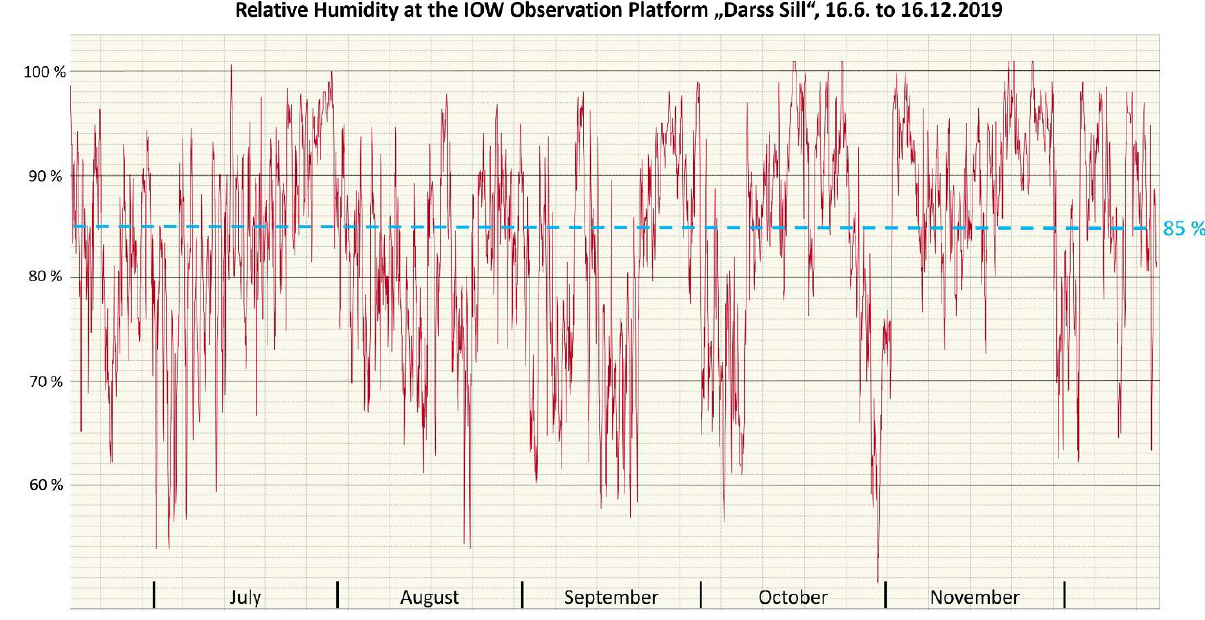
Figure 4. Recorded RH values from 16 June till 16 December 2019 at the IOW observation platform “Darss Sill”, located in the western Baltic Sea between the islands of Hiddensee and Møn. The average over this period is 85 %rh (dashed line). As a rule, meteorological measurement results of RH fluctuate strongly (Figure 4) on the typical time scales of weather between an hour and a month. The mean residence times of water in the troposphere fall in the same interval, Section 2. The stochastic behaviour of RH is statistically similar to that of turbulent air motion [81]. In contrast, the RH values at the sea surface are remarkably stable on climatological timescales [82]. To the current knowledge, those values of about 80 %rh are rather independent of season and region, and they do not exhibit any significant trend in the course of global warming. To this finding it may contribute that suspected systematic changes are expected to become visible only in the range of 0.1 %rh or below, and that the present-day marine and atmospheric measurement technology is